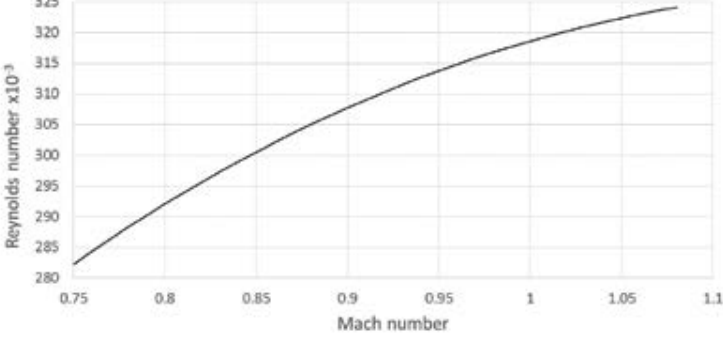
Figure 7. Reynolds number varying Mach number for stagnation pressure of 80 kPa, stagnation temperature of 300 K, and considering the characteristic length as the model diameter of 27.3